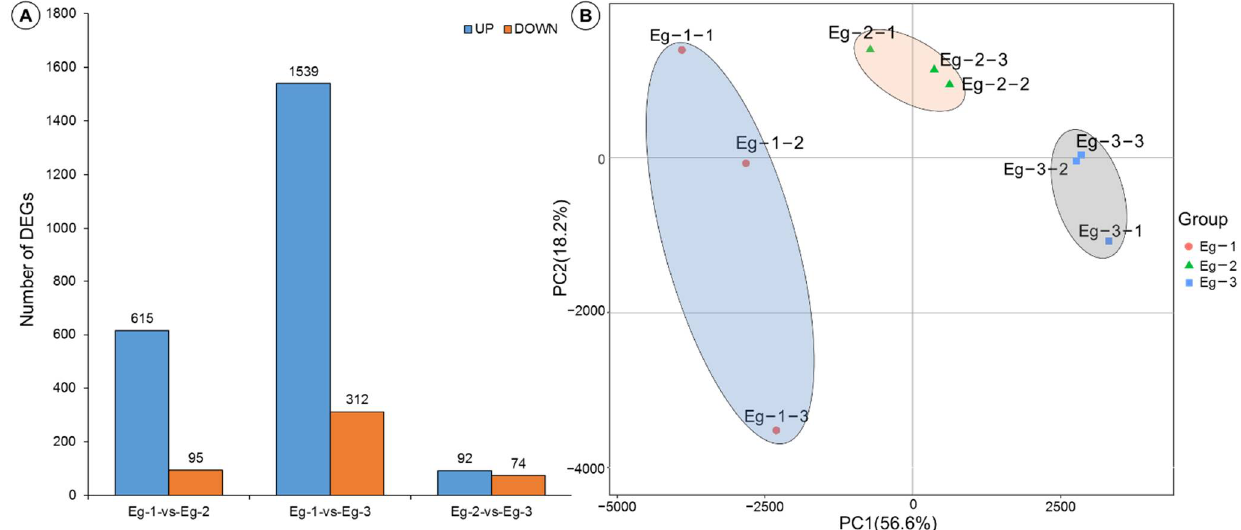
Figure 3. Differentially expressed genes (DEGs) at the three different heights of E. grandis . ( A ) The number of upregulated and downregulated genes in pairwise comparisons between the three different heights. ( B ) The principal component analysis (PCA) of the expressed genes showing sample separation. Principal component 1 (PC1) and PC2 explained 56.6% and 18.2% of the total variance, respectively.